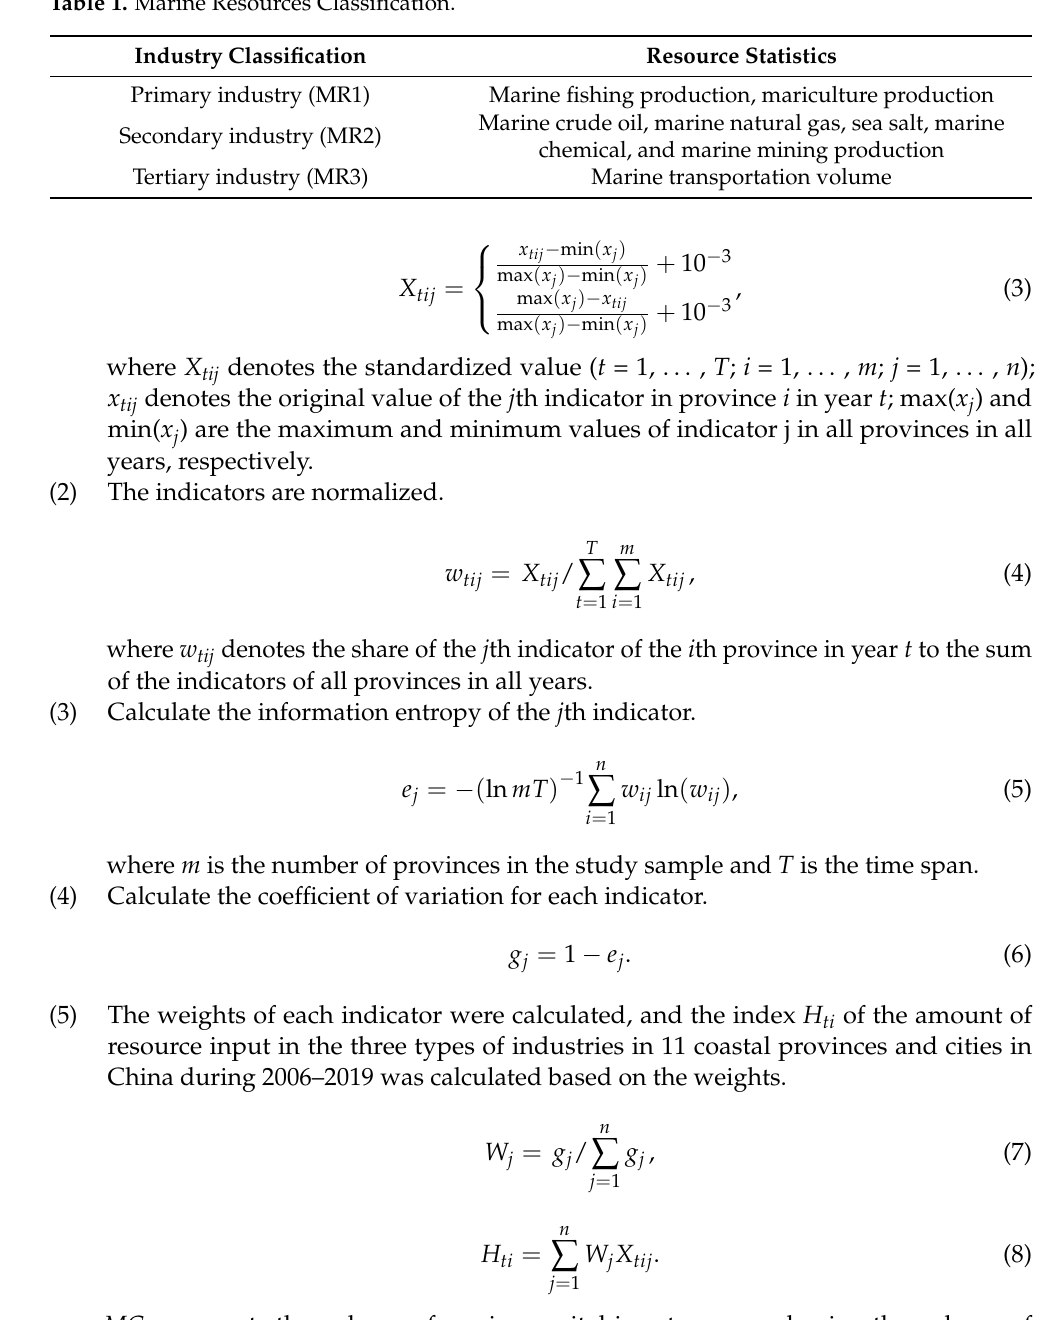
Table 1. Marine Resources